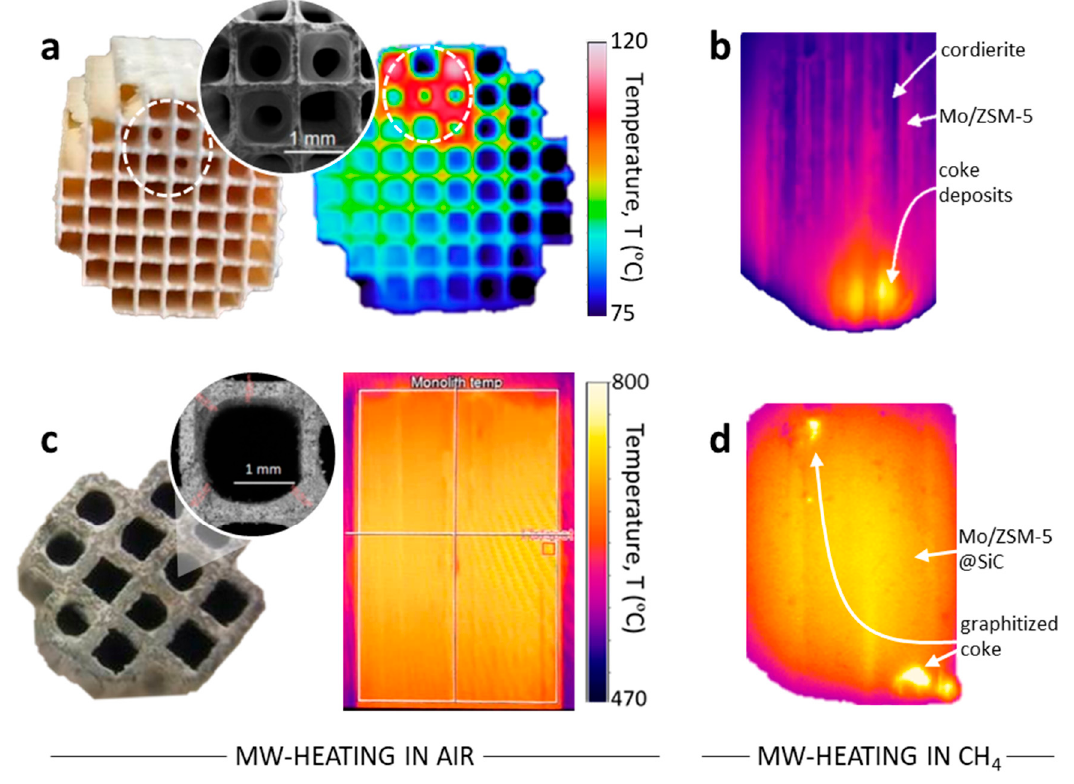
Figure 2. ( a ) Mo/ZSM-5 coated on cordierite monolith: coating detail and top temperature distribution under MW-heating in air; ( b ) Mo/ZSM-5@cordierite heated under CH 4 atmosphere: coke deposits absorb preferentially, uncouple the cavity and lead the structured catalyst to cool down; ( c ) Mo/ZSM-5 coated on β -SiC: coating detail and lateral temperature distribution under MW-heating in air; ( d ) Mo/ZSM-5@SiC heated under CH 4 atmosphere: hot spots formed due to coking do not disturb heating homogeneity and do not modify the average temperature along the structured catalyst. Thermal images were acquired with an infrared camera (Optris PI 1 M) pointing at the lateral wall of the MW- sample.